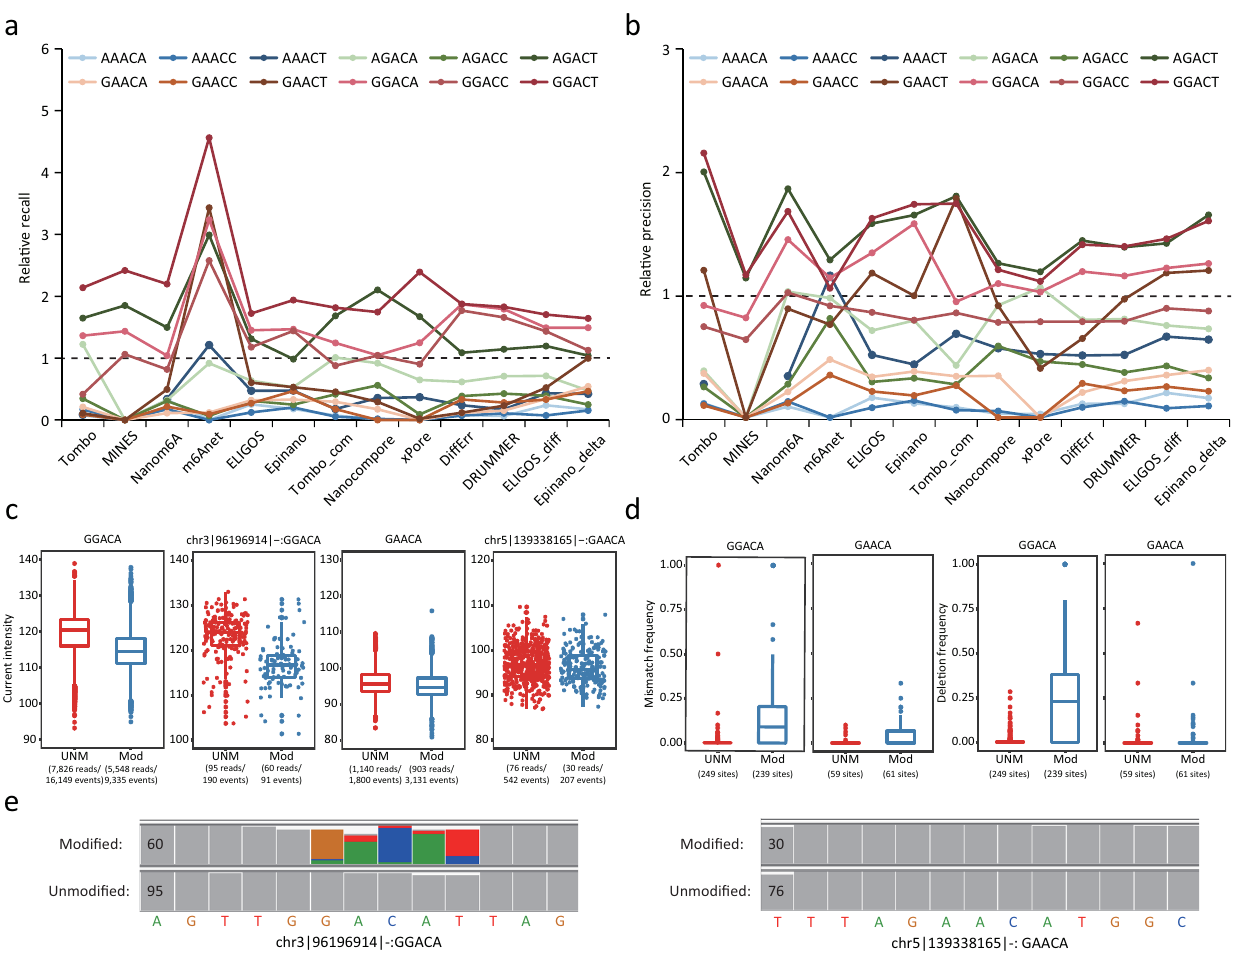
Fig. 4 | Detection capabilities for m6A among sequence motifs. a , b Relative recall rates ( a ) and precision ( b ) for 12 motifs bearing the consensus sequence RRACH. Relative recall rates/precision were calculated as the ratio of the recall/ precisionforthesitesinaspeci fi cmotiftotheoverallmean(acrossallsites).Am6A pro fi le created from miCLIP results was used for validation. c Current intensity of modi fi ed and unmodi fi ed sites in GGACA or GAACA motifs. The m6A candidate sites (methylation rate of WT – KO>0.8) were identi fi ed using m6A-REF-seq and markedas “ Mod ” (modi fi ed,sitesinWTsample)or “ UNM ” (unmodi fi ed,sitesinKO sample).Thisdatasetwasalsousedin d , e .Forboxplotsin c , d ,theupperandlower